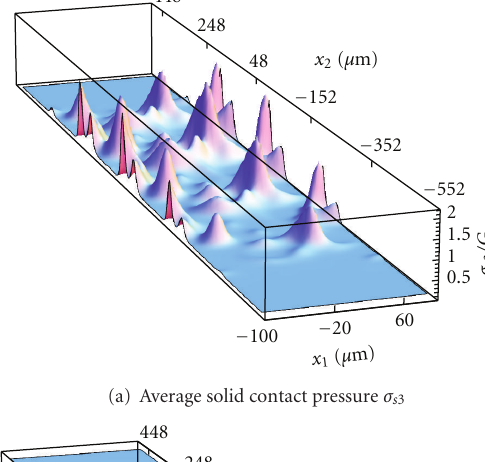
Figure 4: Dimensionless average interfacial separation u/h rms as a function of contact position, reported in the undeformed reference.